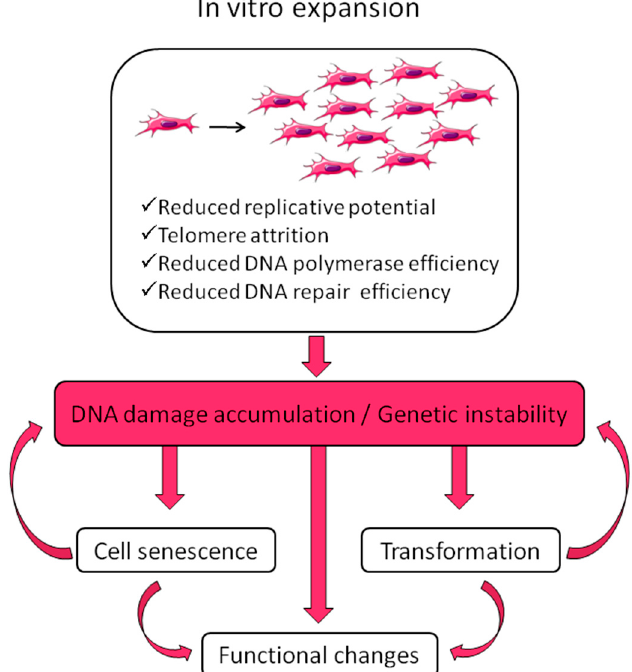
Figure 1. Effects of in vitro expansion. During in vitro expansion cells reduce their replicative potential and accumulate DNA damage due to progressively reduced DNA synthesis and repair efficiencies. DNA damage accumulation can affect genomic integrity of the cells possibly driving senescence and transformation, with consequent functional alterations. These can impair the therapeutic effect and raise safety issues.